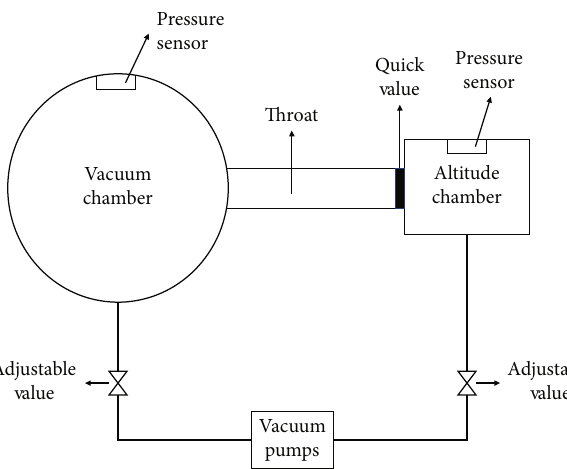
Figure 1: Rapid decompression system of the altitude